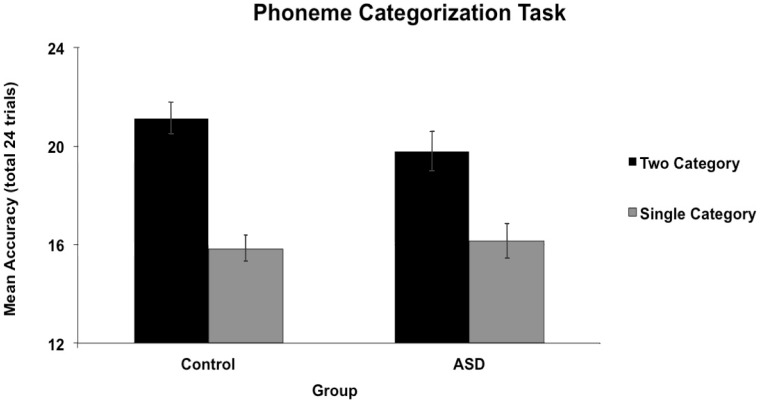
Mean accuracy for the Phoneme Categorization Task by group.In a 3-interval forced choice design, subjects heard three phonemes that fell into two categories in either the pattern ABB or AAB and had to determine whether the middle sound was most similar to the first or last sound. The number correct out of 24 is shown on the y-axis for the cases where the speech sounds fell into one or into two phonemic categories in the native language. Error bars represent standard error of the mean. Group differences were found such that those with ASD showed a significantly smaller difference than controls between the two-category and one-category mapping conditions.